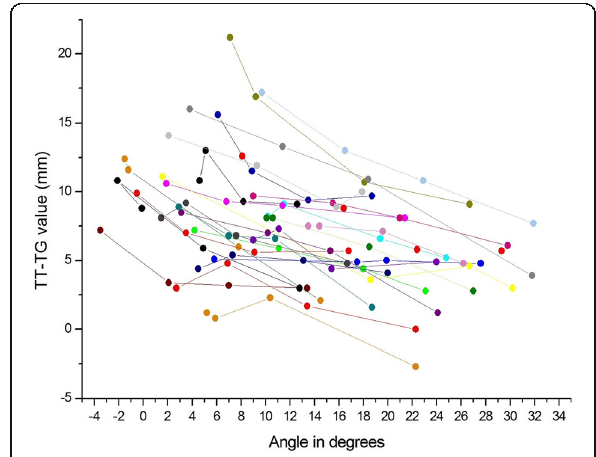
Fig. 2 Individual TT – TG values in different knee flexion angles measured from magnetic resonance